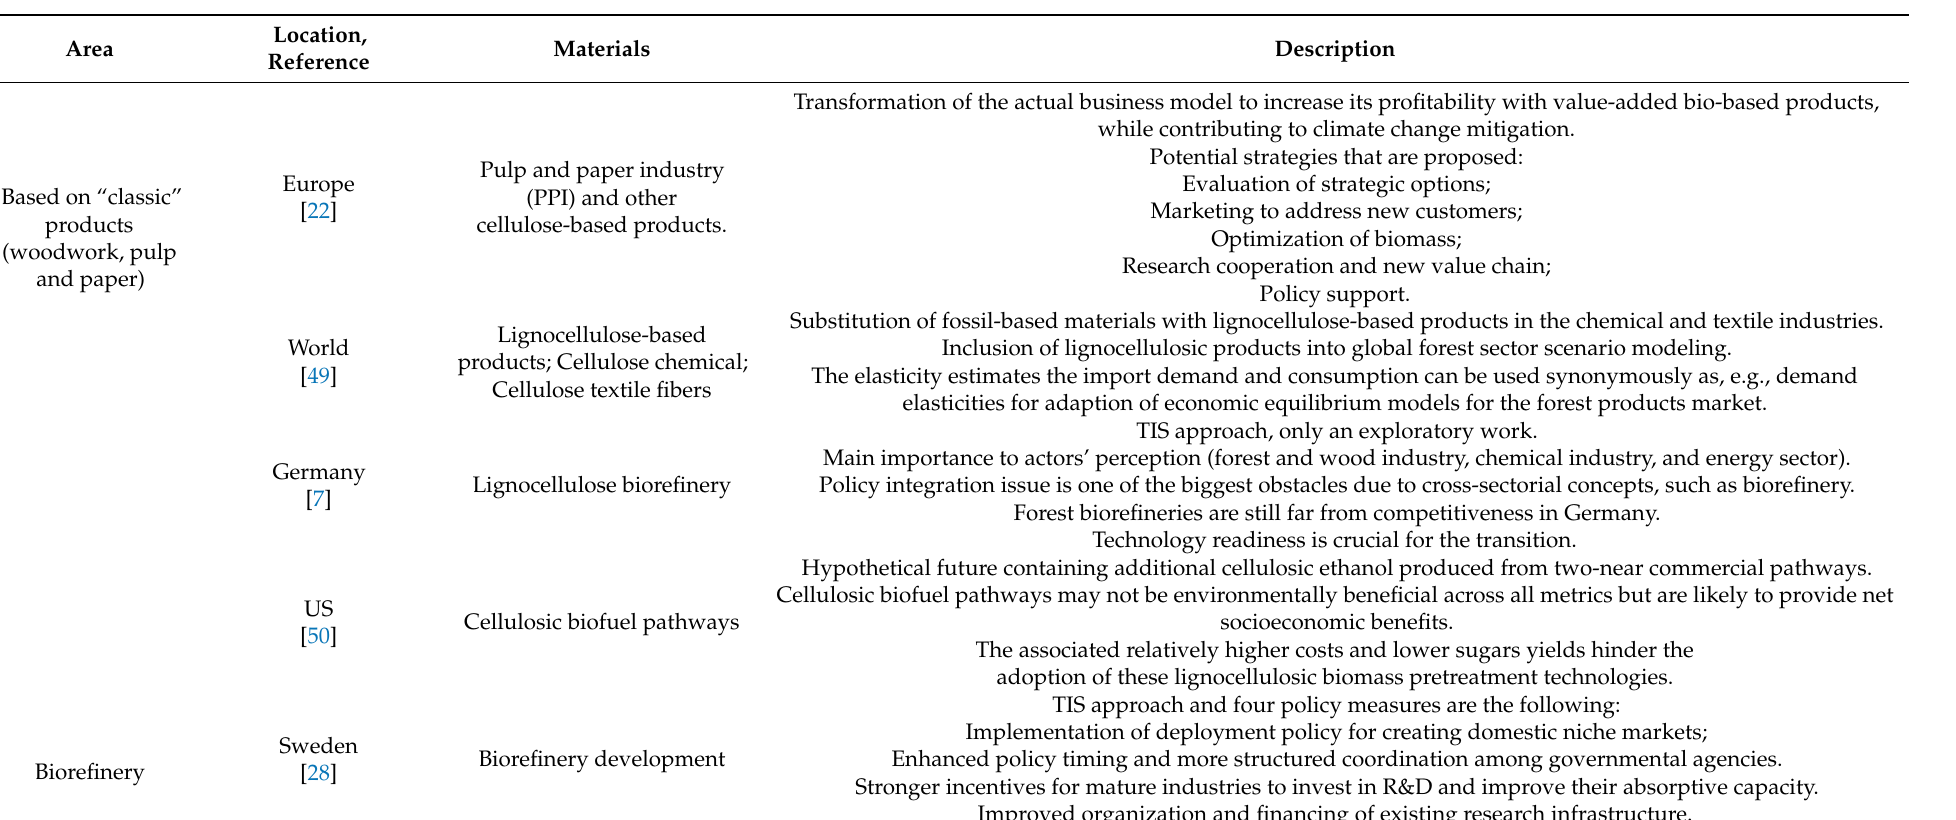
Table A1. Summary of forest bioeconomy innovations across their different